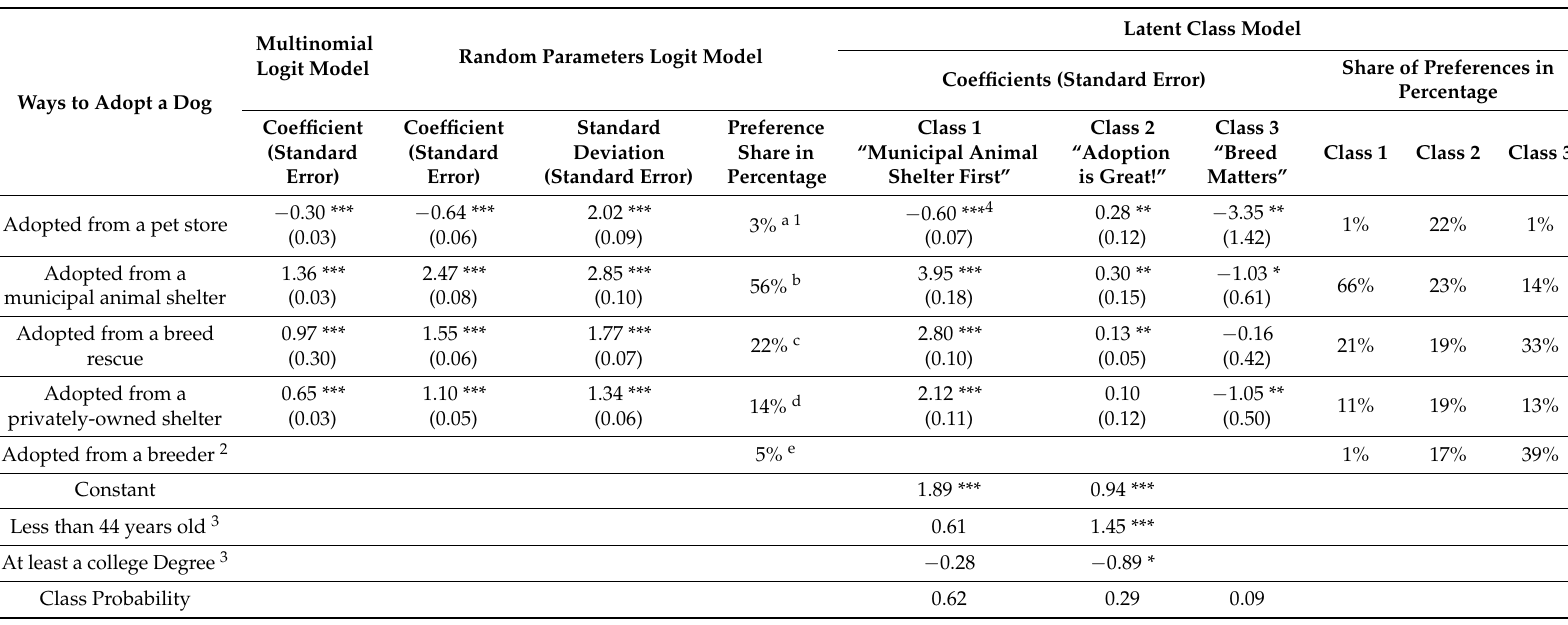
Table 6. Multinomial logit model, random parameters logit model and latent class model results for most ethical way to adopt a dog, coefficients and preference shares (n =